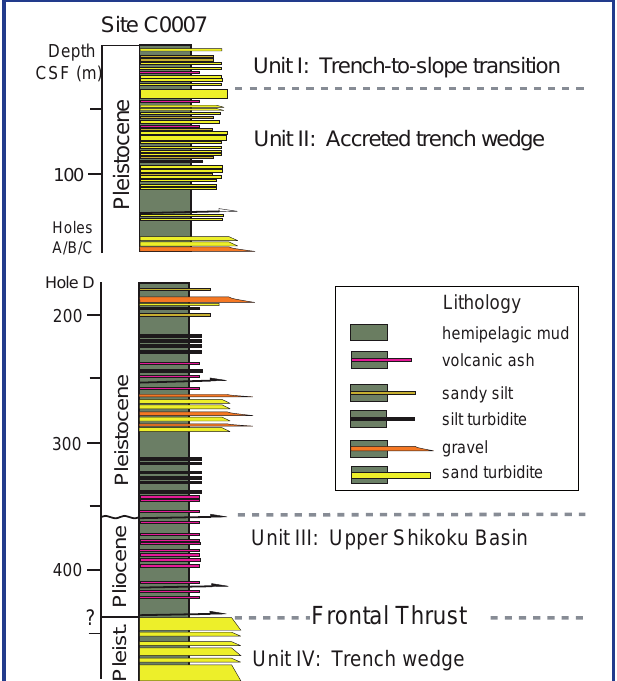
Figure 4. Hole C0007D summary of coring, lithology, and major